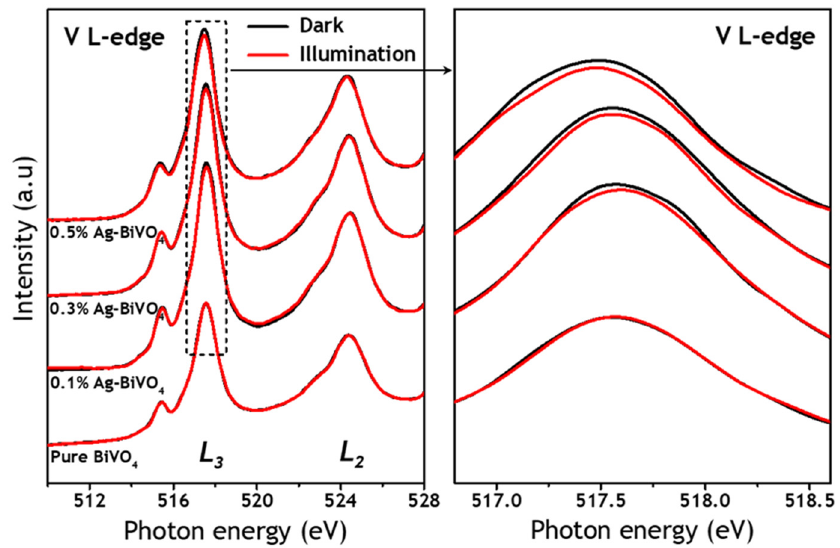
Figure 6. In situ XAS at V L-edge of the samples in the dark and under solar illumination.